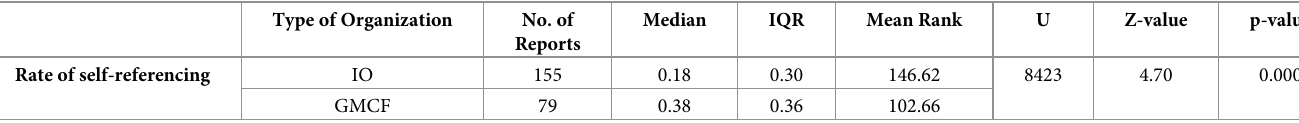
Table 3. Mann-Whitney U test of rate of self-referencing across IOs and GMCFs.